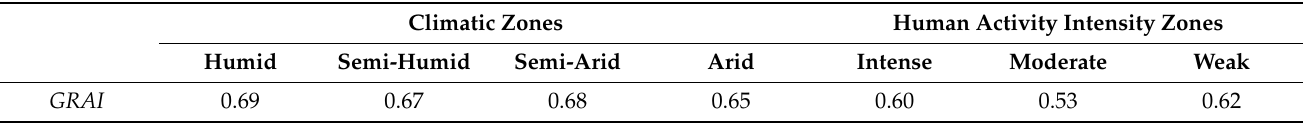
Table 6. Average GRAI of the different climatic and human activity intensity